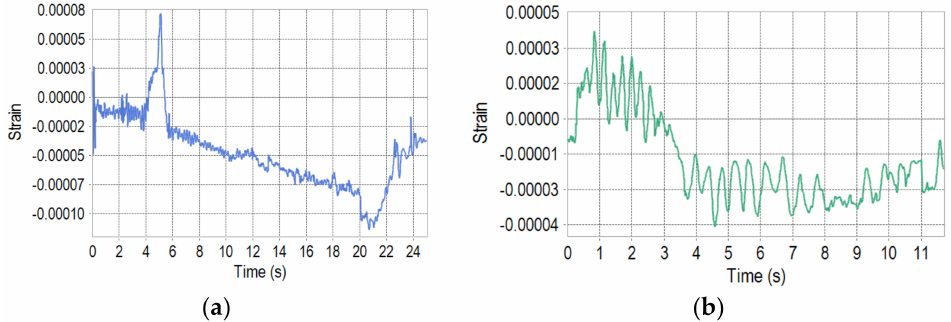
Figure 16. Strains of the right push arm: ( a ) simulation results; ( b ) experiment